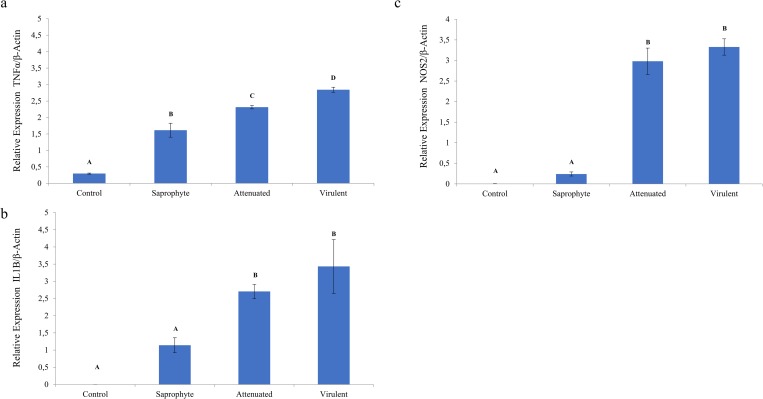
qRT-PCR of mRNA expression levels in infected macrophages with different strains of Leptospira compared to non-infected controls.Panel A) Relative expression of TNF-α in saprophyte, culture-attenuated and virulent compared to control. Panel B) Relative expression of IL-1β in saprophyte, culture-attenuated and virulent compared to control. Panel C) Relative expression of NOS2 in saprophyte, culture-attenuated and virulent compared to control (p <0.05). Different superscript letters differs significantly (p <0.05).